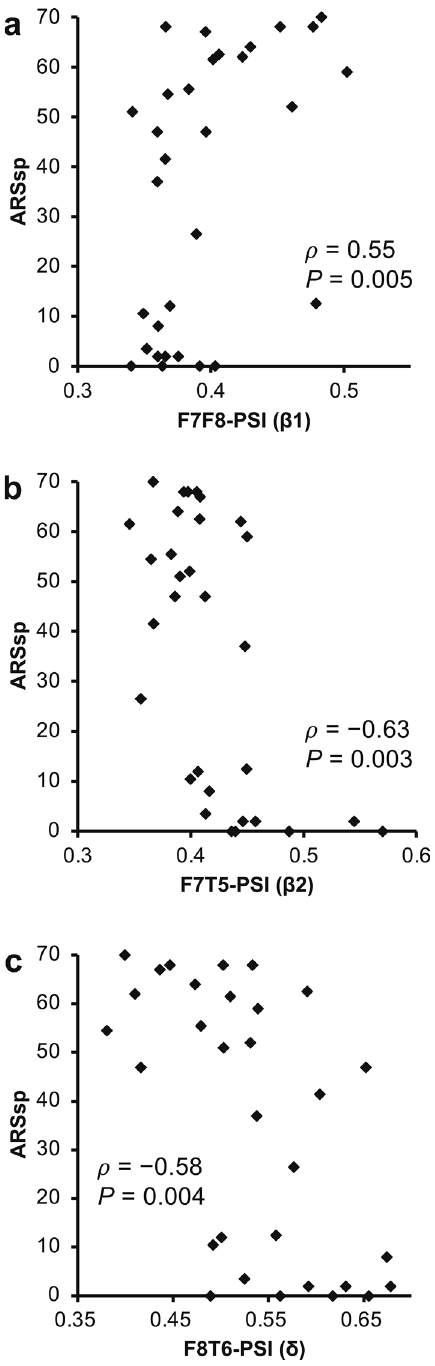
Figure 3. Correlation of the F7F8/F7T5/F8T6-PSIs with ARSsp scores. Scatter plots of the ( a ) F7F8-PSI, ( b ) F7T5-PSI, and ( c ) F8T6-PSI versus the ARSsp scores ( P values: Spearman’s correlation analysis; FDR corrected). The F7F8-PSI is correlated positively with the ARSsp score, whereas the F7T5-PSI and F8T6-PSI are correlated negatively with the ARSsp scores. ARSsp Aphasia Rating Scale speech, FDR false discovery rate, PSI phase synchrony